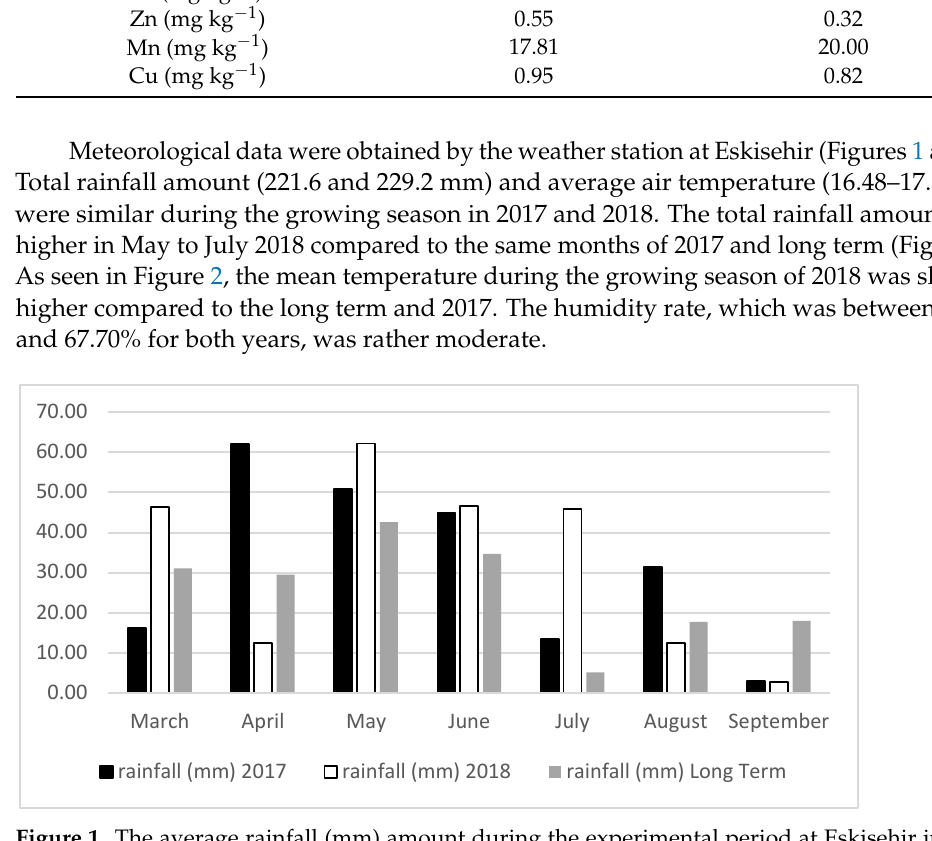
Figure 1. The average rainfall (mm) amount during the experimental period at Eskisehir in 2017, 2018 and long term.